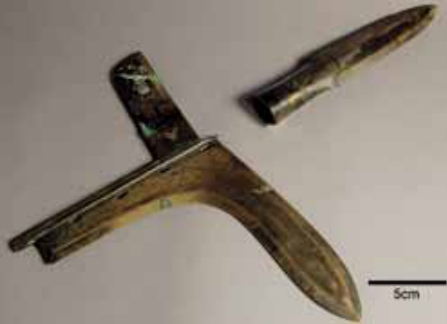
Fig. 3: A bronze halberd from the Terracotta Army; note the sharpness of the blades and good state of types across the excavated area. These images and, implicitly therefore, of the military strat- egies of the Qin army. For example, one can easily see how seemingly lower-status robed warriors were placed on the front line, fol-